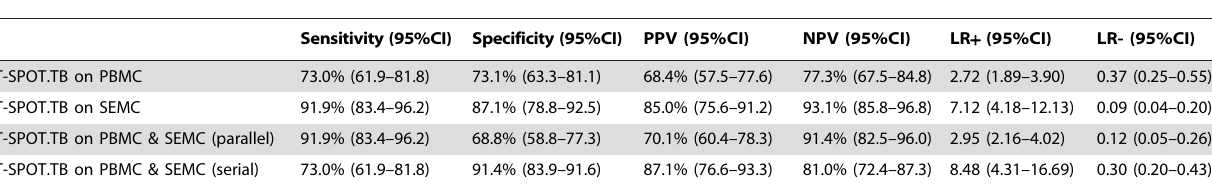
Table 3. Single and combined diagnostic parameters of T-SPOT.TB on SEMC and PBMC.